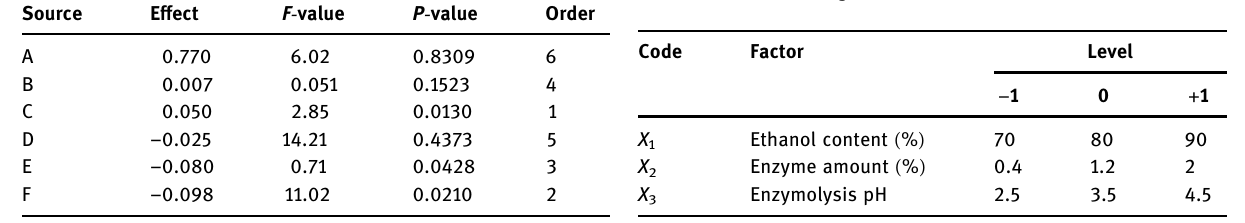
Table 3: Estimated regression coe ffi cients of the Plackett – Burman experiment